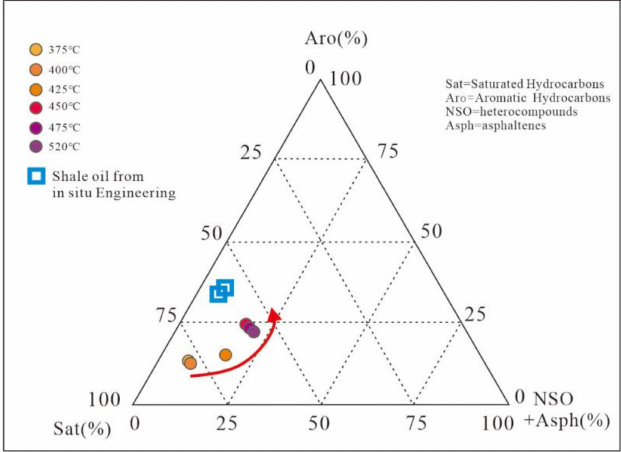
Figure 6. Variation in the pyrolysis oil